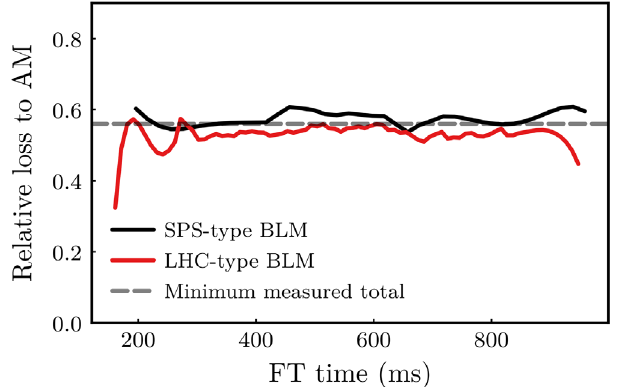
FIG. 21. Time evolution of the loss reduction for the optimized case in channeling presented in Fig.